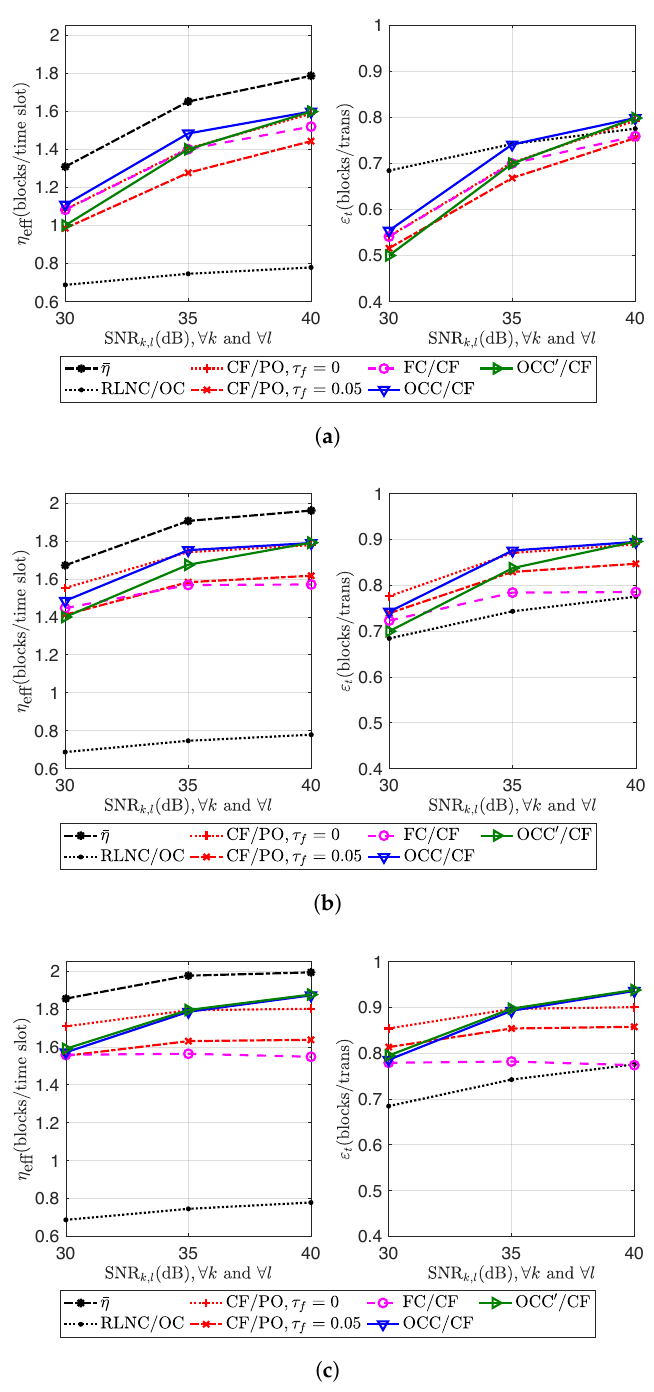
Figure 11. Channel efficiency and transmission efficiency for Scenario 2. ( a ) Two-source two-relay network; ( b ) two-source three-relay network; ( c ) two-source four-relay network. From Figure 10, OCC/CF and OCC (cid:48) /CF increased channel efficiency by 72.98% and 63.28%, respectively, on average if comparing with RLNC/OC. For τ f = 0.05, OCC/CF had a 4.71% increment of channel efficiency on average if comparing with CF/PO. However, OCC/CF and OCC (cid:48) /CF provided higher channel efficiency than CF/PO only when SNR 1,2 or SNR 2,1 was similarly high as SNR 1,1 or SNR 2,2 , i.e., when the participation factor of source k was dense around θ k = d k for all k . OCC/CF and OCC (cid:48) /CF provided the increment of channel efficiency up to 16.41% and 13.41% if comparing